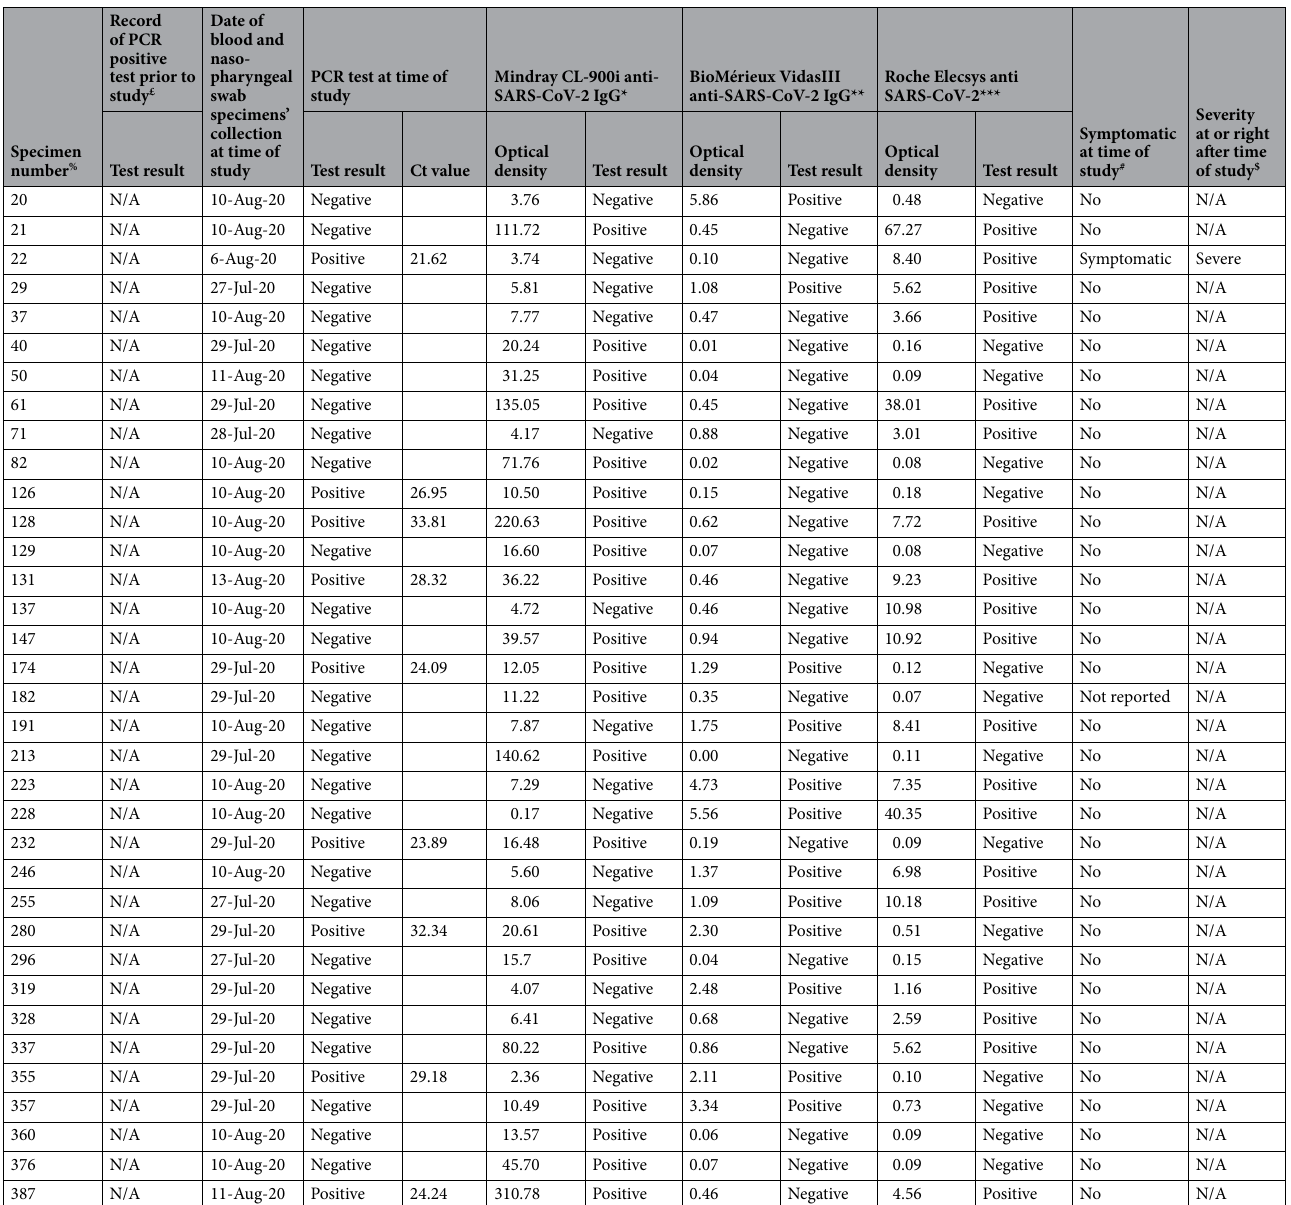
Table 1. Characteristics of the specimens that were discordant among the Mindray CL-900i anti-SARS-CoV-2 IgG, BioMérieux VidasIII anti-SARS-CoV-2 IgG, and Roche Elecsys Anti SARS-CoV-2 antibody testing.